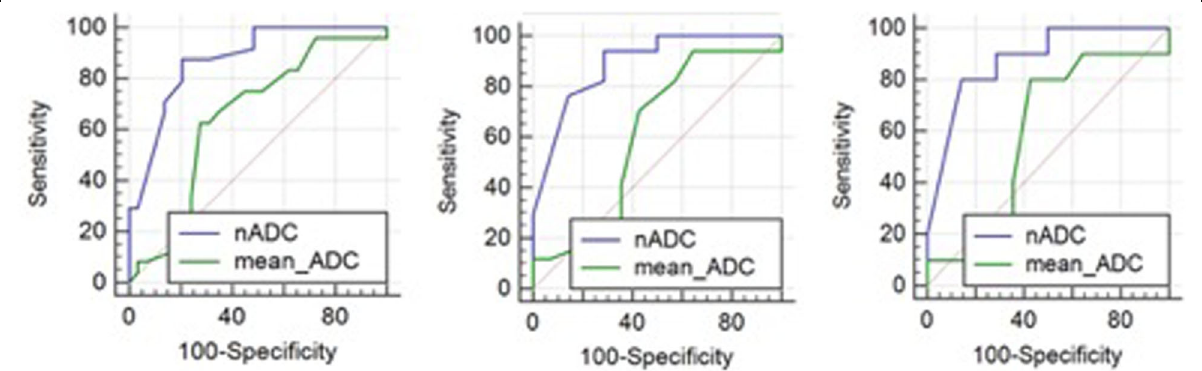
Fig. 4 Receiver operating characteristic curves (ROC) for liver apparent diffusion coefficient (ADC; green line) and normalized liver ADC (blue line). It differentiates the patients into different fibrosis stages (A-detection of stage ≥ 2, left curve; B-detection of stage ≥ 3, middle curve; C-detection of cirrhosis [stage 4], right